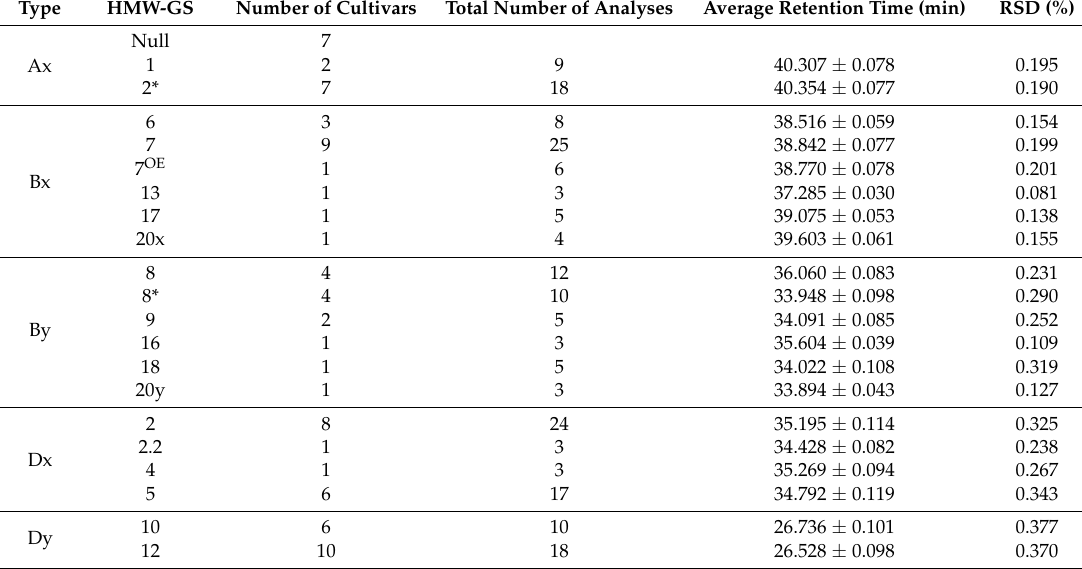
Table 2. Reproducibility of RP-HPLC retention times for HMW-GS in standard wheat